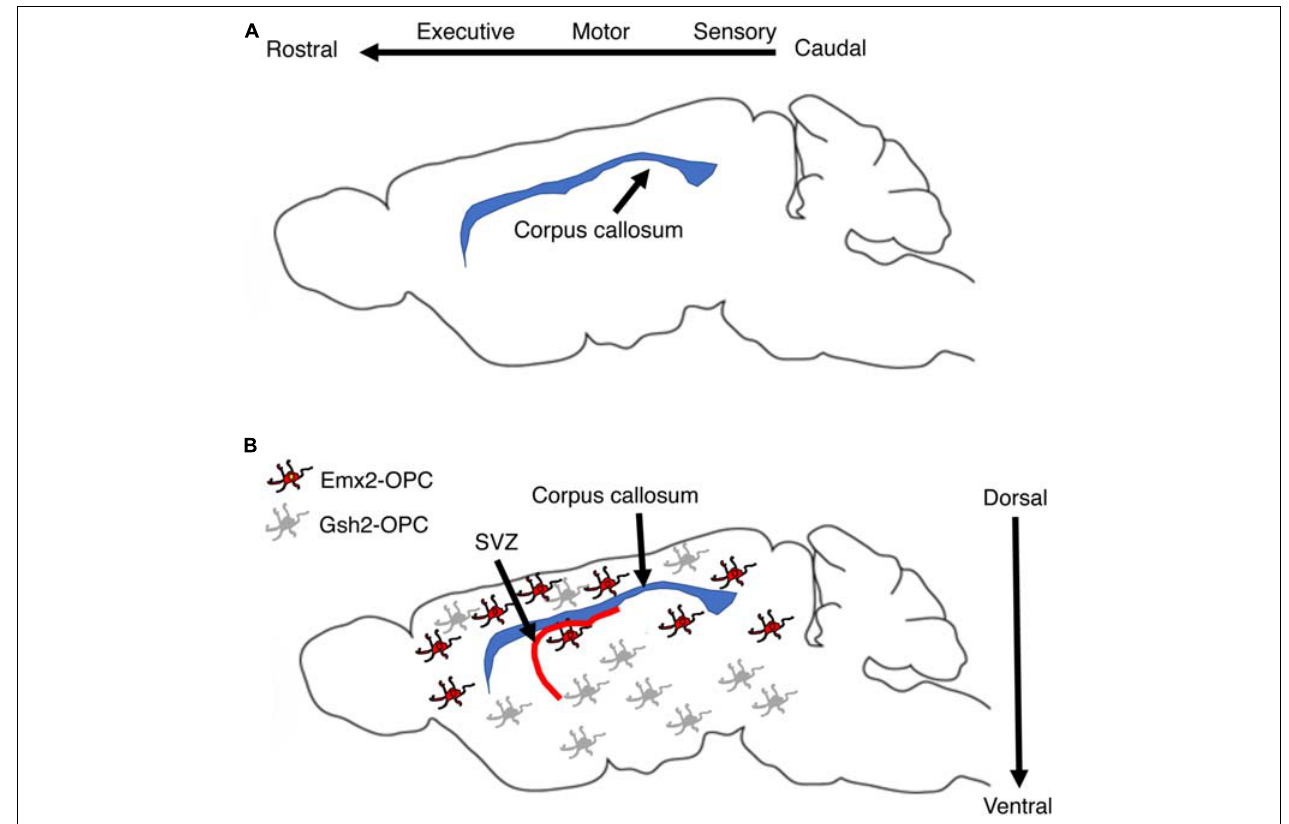
FIGURE 3 | Corpus callosum and myelin development. (A) Myelination in the corpus callosum proceeds from caudal to rostral to ensure sequential maturation of circuits that enhance attachment and escape behavior early in life. (B) OPCs are a large, heterogenous and somewhat redundant cell population that undergoes significant changes in composition during the first 10 days after birth. Emx2-OPC (red) populate the dorsal telencephalon, appear to be mammalian specific, and are highly responsive to demyelinating conditions. Gsh2-OPC (gray) are present in both the dorsal and ventral telencephalon. Both Emx-2 and Gsh2 OPC continue to be generated throughout life from the SVZ (red). OPCs, oligodendrocyte progenitor cells.